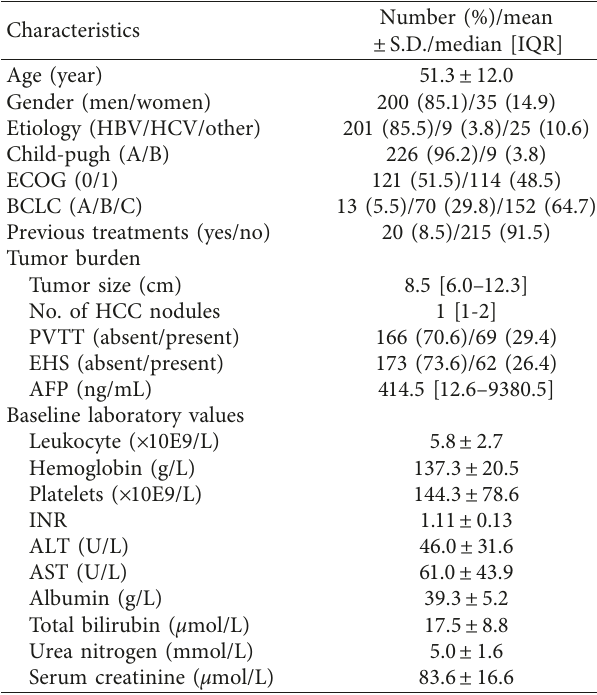
Table 1: Baseline demographics and clinical characteristics of the patients ( N �